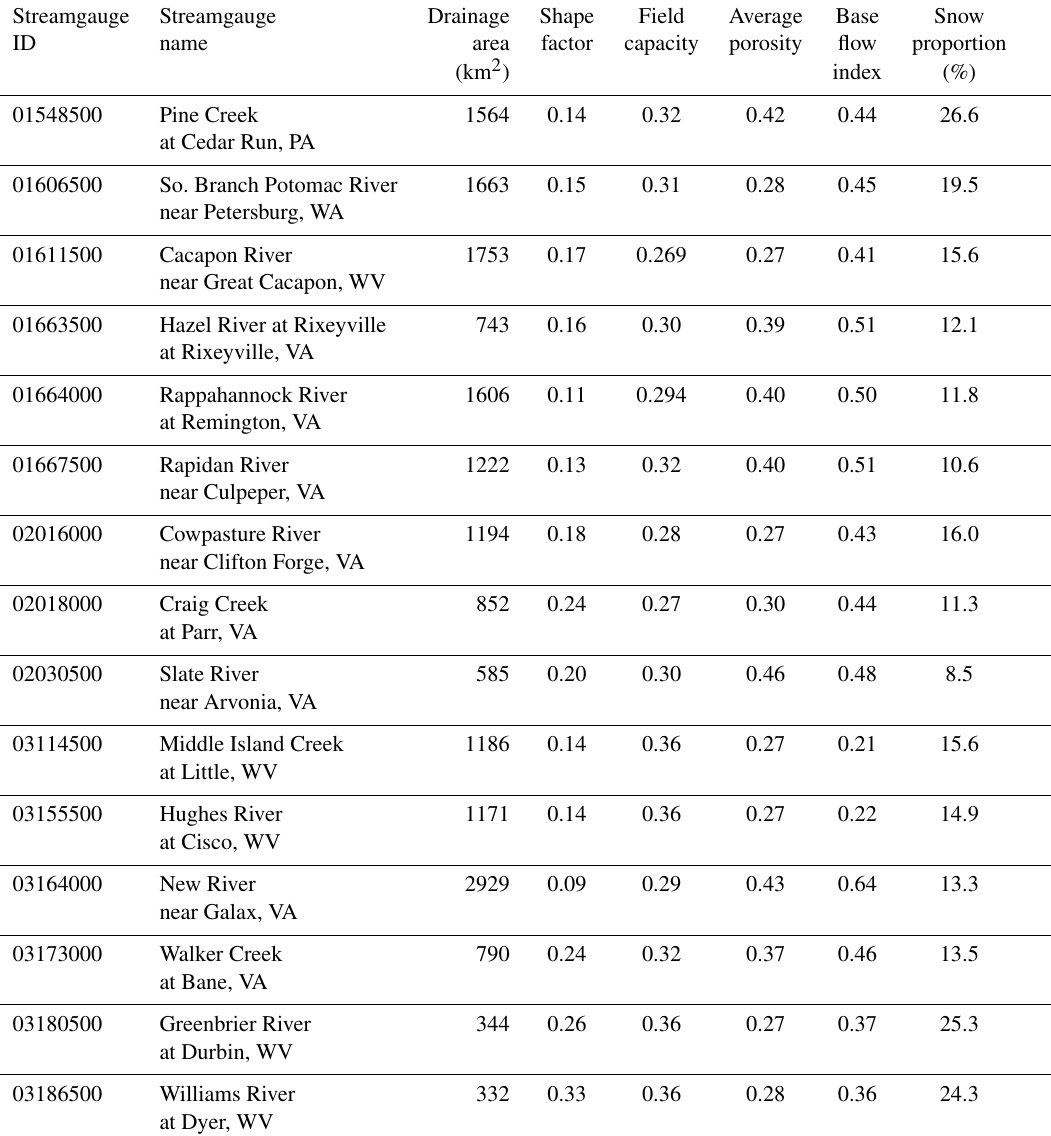
Table 1. Catchment properties for the selected 15 catchments. Streamgauge Streamgauge Drainage Shape Field Average Base Snow ID name area factor capacity porosity